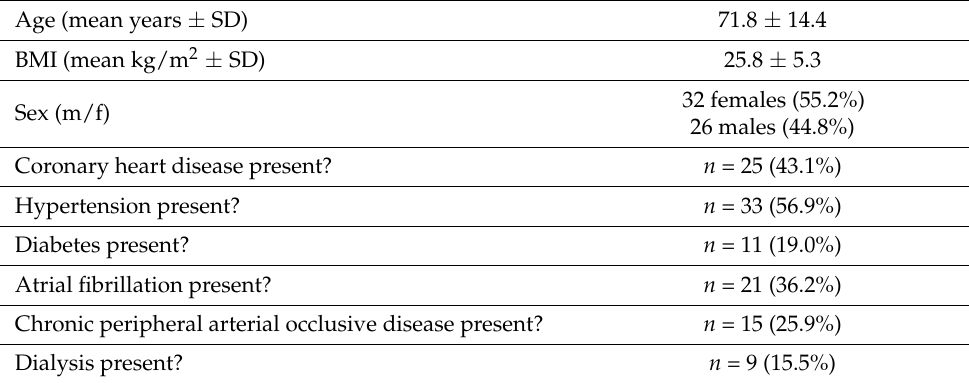
Table 1. Patient characteristics at the time of mesenteric ischemia. All the values are given as median ± standard deviation. BMI: body mass index.